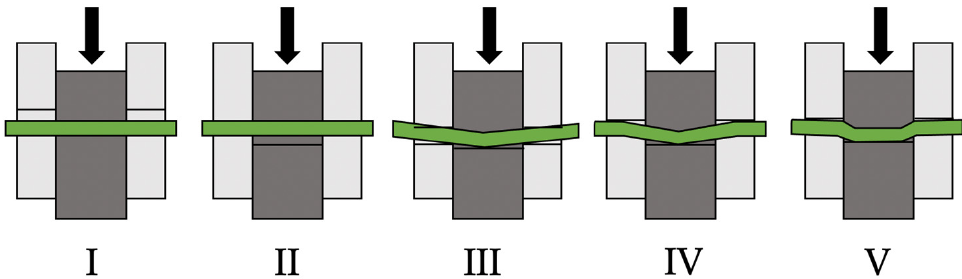
Figure 15. Failure modes of timber-to-timber joints with wooden dowels. Redraw from [117].